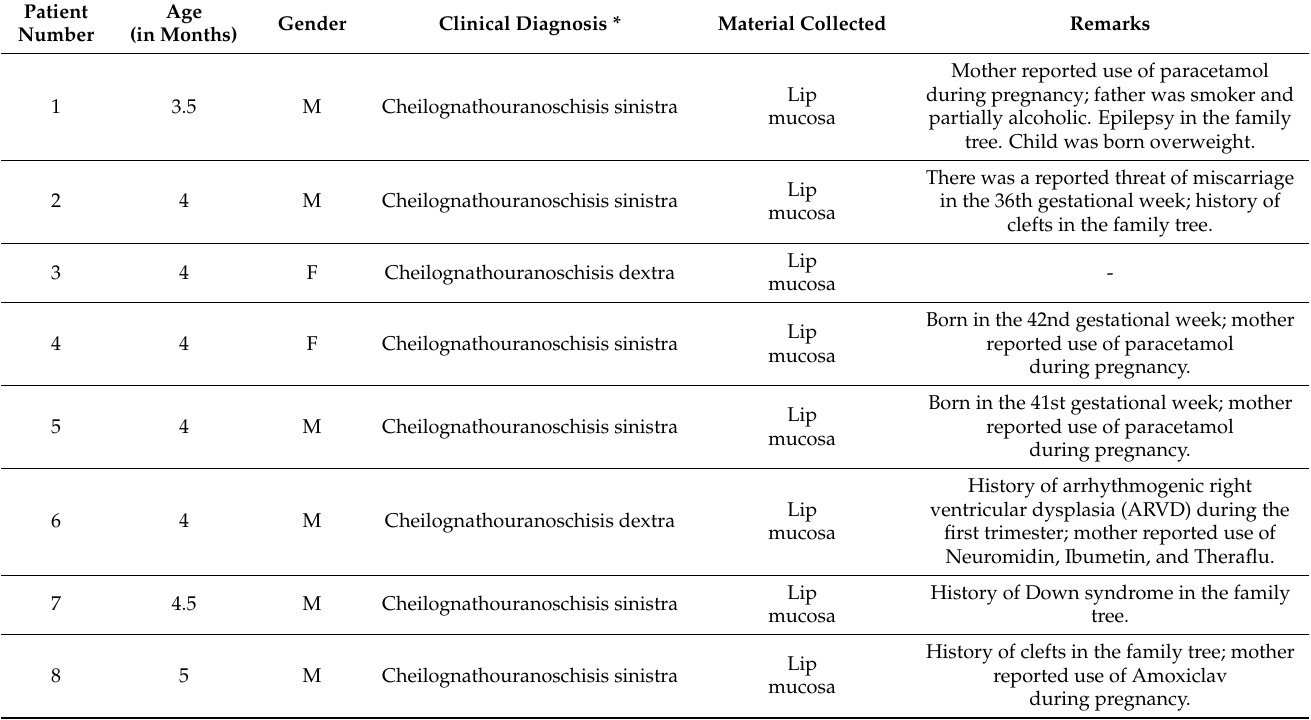
Table 1. Profile of study participants and clinical